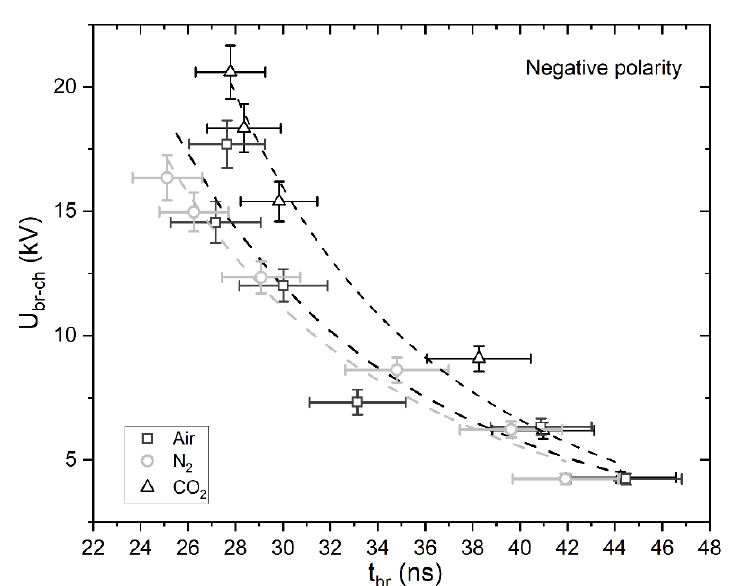
Figure 7. The breakdown voltage, U br-ch , as function of t br , negative polarity: —air; ○ —N 2 ; △ —CO 2 . Dashed lines show fitting curves for each gas obtained by Equation (3).The error bars show the 95% confidence interval in the breakdown voltage and time to breakdown.